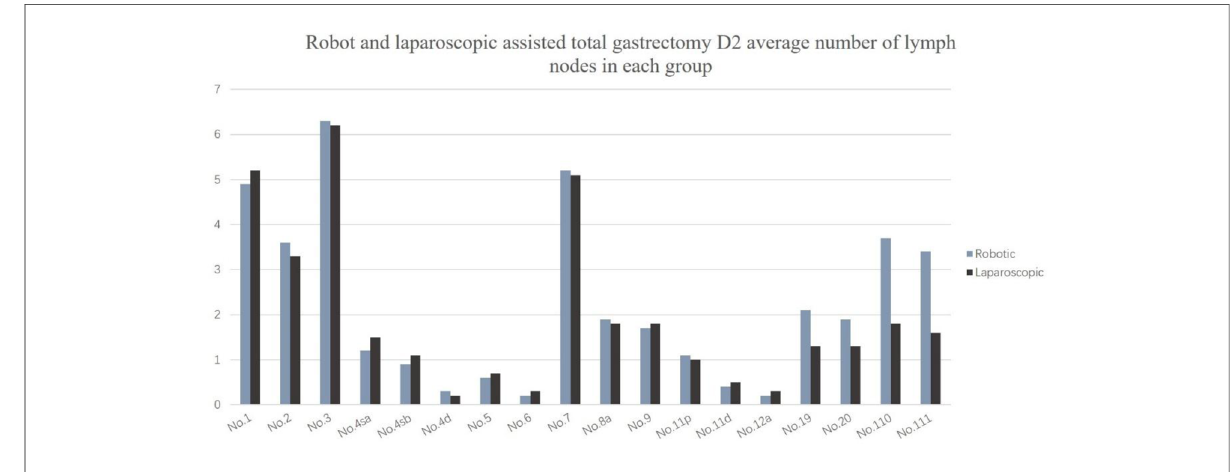
FIGURE 2 Robot and laparoscopic assisted total gastrectomy D2 average number of lymph nodes in each group.